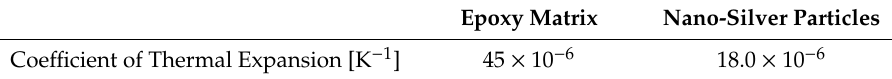
Table 3. Thermal coe ffi cient of expansion of fillers and the